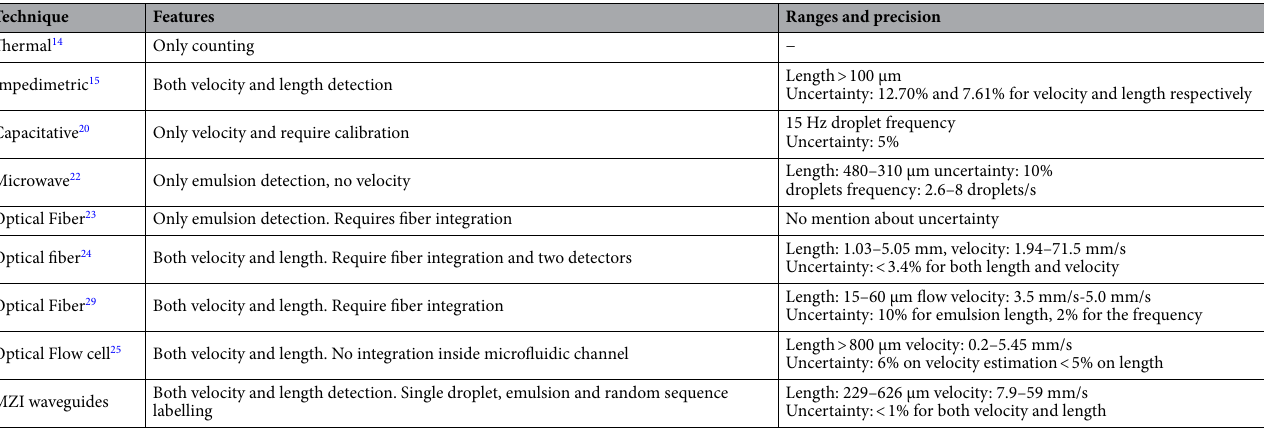
Table 2. Comparison between different integrated for the measurements of lengths and velocity of flowing